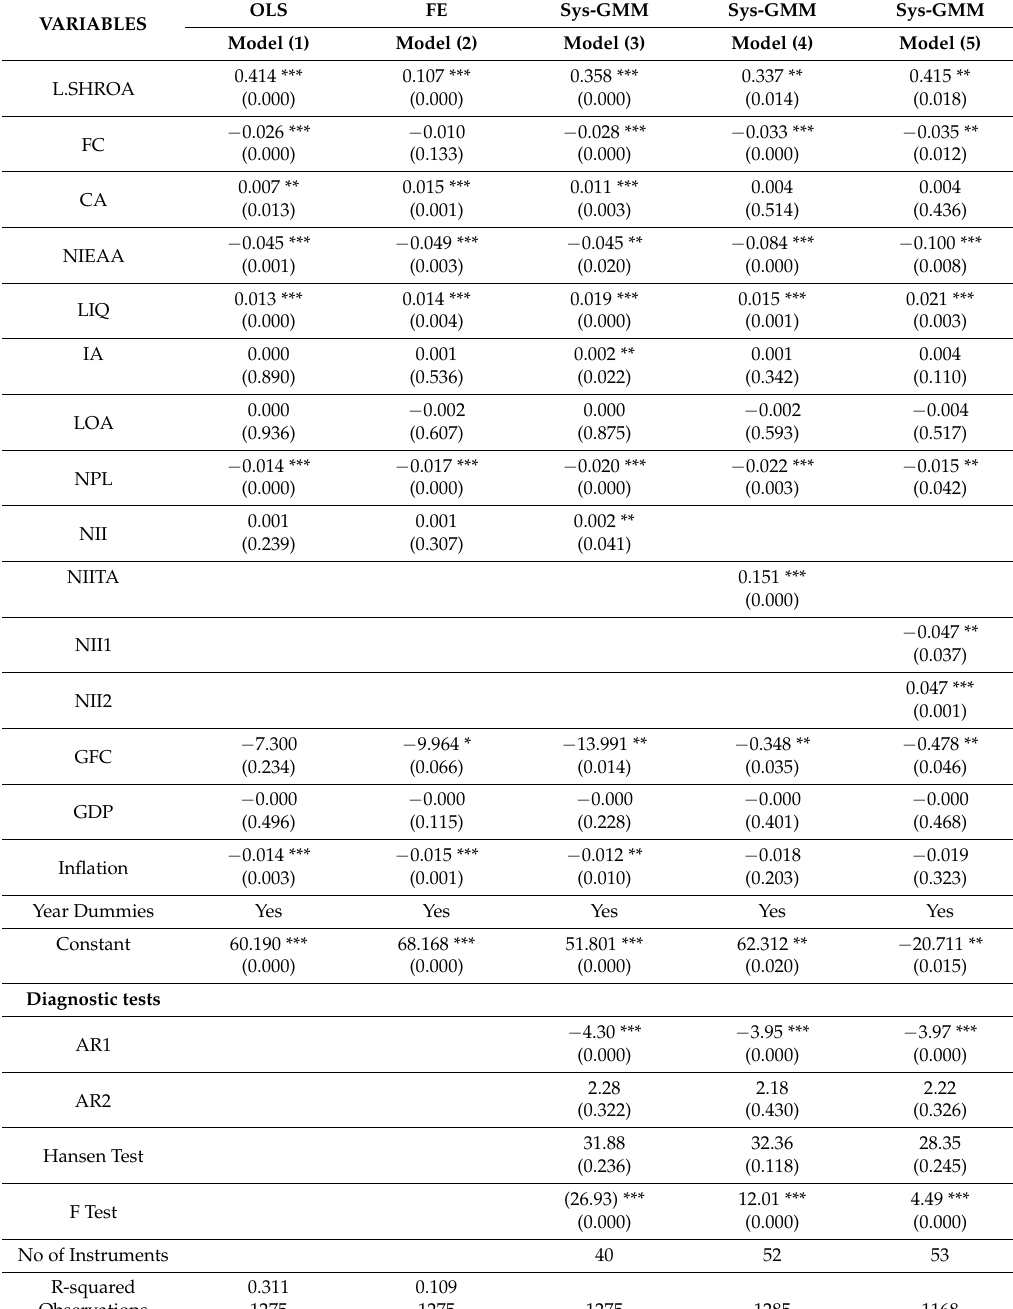
Table 6. Results for risk adjusted return on assets (SHROA) (bank stability) as dependent